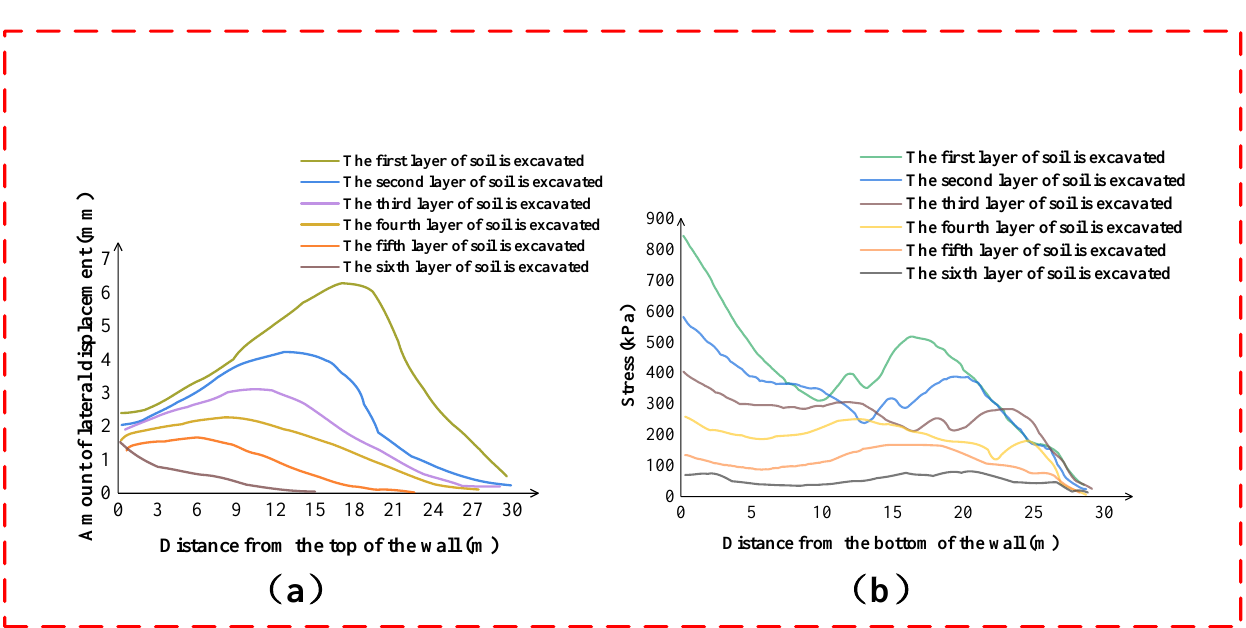
Figure 16. Comparison diagram of lateral displacement and stress of a continuous underground wall: ( a ) lateral displacement comparison diagram of underground diaphragm wall; ( b ) stress comparison diagram of underground diaphragm wall after excavation.